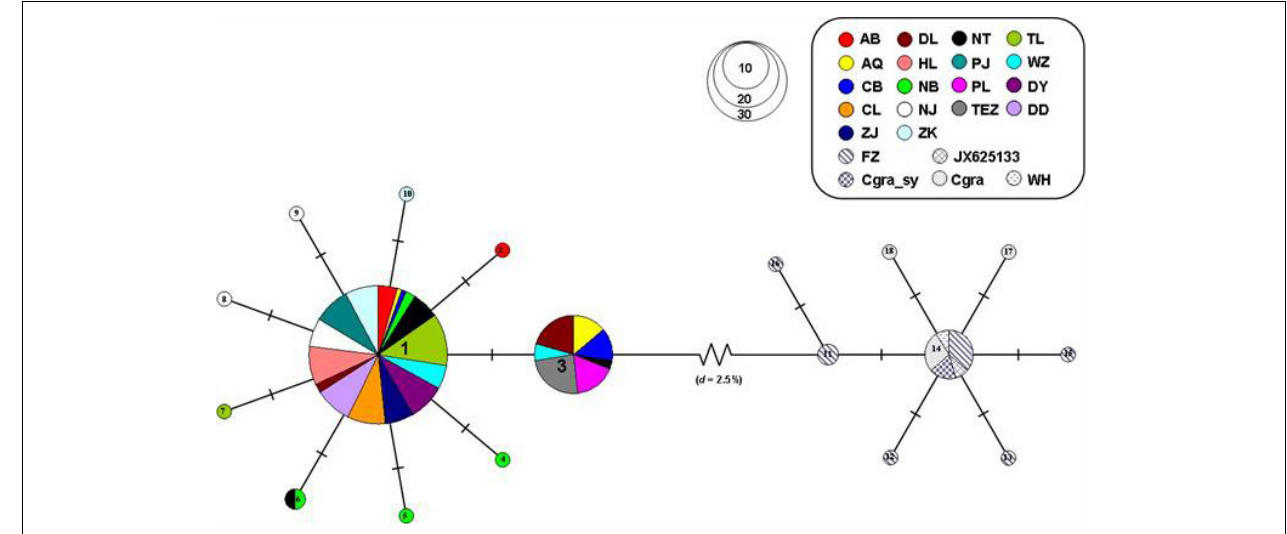
FIGURE 4 | MST showed genetic relationship among mtDNA Cyt b haplotypes for C. nasus